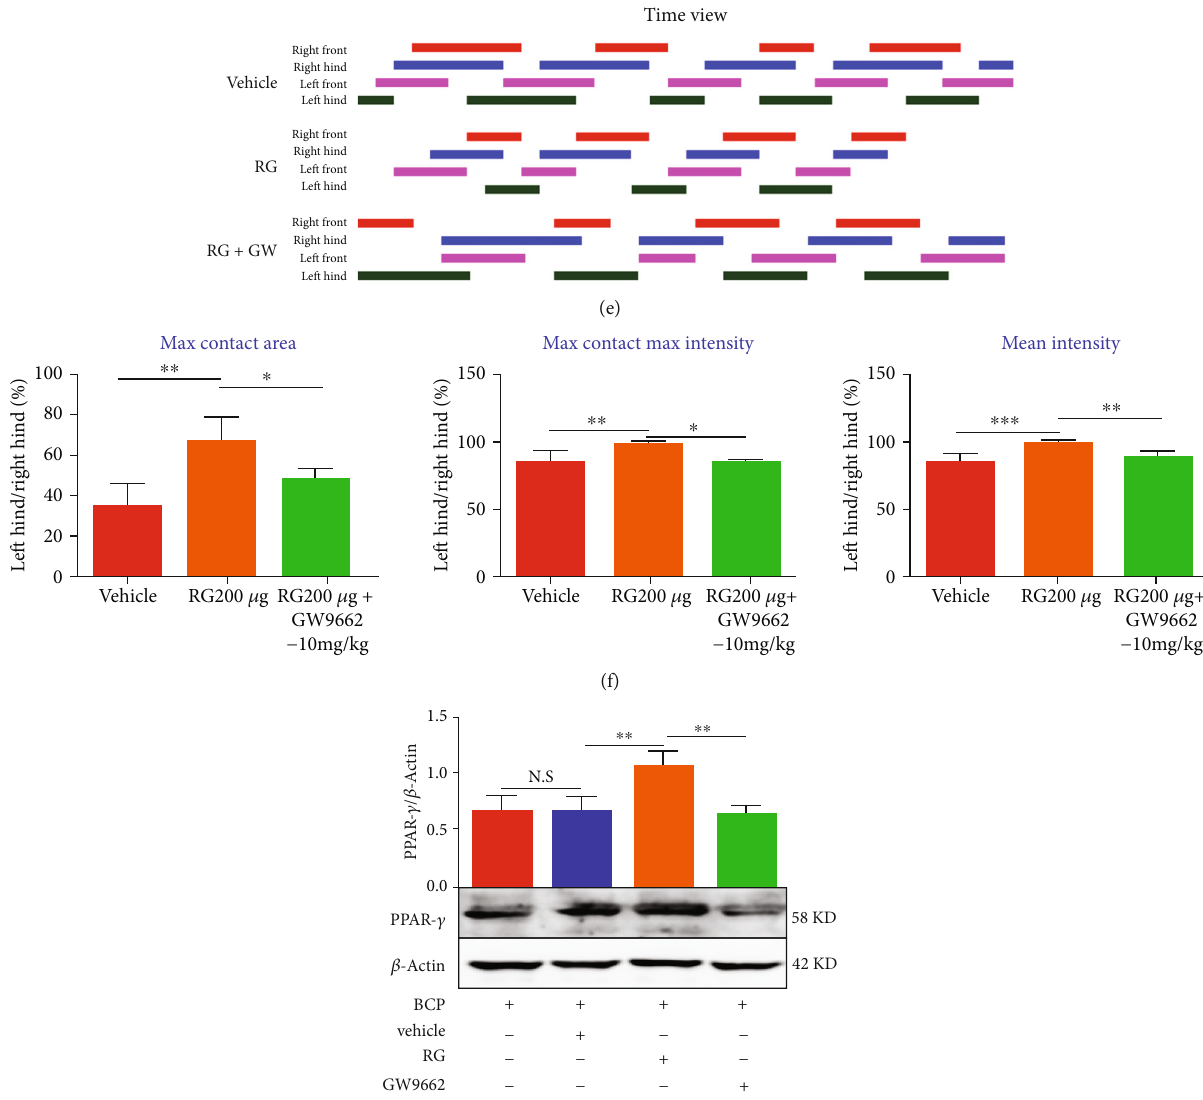
Figure 3: Rosiglitazone attenuated bone cancer pain (BCP) by activating proliferator-activated receptor- γ (PPAR- γ ). (a) Compared to that of rats in the vehicle-treated BCP group, repeated intrathecal injection of rosiglitazone at 50, 100, and 200 μ g signi fi cantly increased the paw withdrawal threshold (PWT) of BCP rats in a dose-dependent manner from postoperative days (POD) 14 – 18 ( ∗ p < 0 : 05 and ∗∗∗ p < 0 : 001 vs. the vehicle control group; n = 6 , two-way repeated measures ANOVA (a)). (b) A single dose of rosiglitazone (50, 100, and 200 μ g) reversed mechanical hypersensitivity in the later stages of BCP in a dose-dependent manner ( ∗ p < 0 : 05 , ∗∗ p < 0 : 01 , and ∗∗∗ p < 0 : 001 vs. the vehicle control group; n = 6 , two-way repeated measures ANOVA (b)). (c) The PPAR- γ antagonist GW9662 reversed the analgesic e ff ect of rosiglitazone in BCP rats ( ∗ p < 0 : 05 and ∗∗∗ p < 0 : 001 vs. the BCP+RG group; n = 6 , two-way repeated measures ANOVA (c)). Rosiglitazone and GW9662 treatment did not a ff ect the basal pain threshold of sham rats ( p > 0 : 05 vs. the vehicle control group; two-way repeated measures ANOVA (c)). (d, e) Representative CATWALK gait analysis results, including print view and timing view in the BCP, BCP+rosiglitazone, and BCP+rosiglitazone+GW9662 groups. Print area is the size of the paw print. Print time represents the related contact time. (f) Compared with those in the BCP group, the percentages of left/right hind paw ratio of maximum contact area, maximum contact maximum intensity, and mean intensity were signi fi cantly increased in the group treated with 200 μ g rosiglitazone ( ∗∗ p < 0 : 01 and ∗∗∗ p < 0 : 001 vs. vehicle control group; n = 6 , one-way ANOVA (f)), which was reversed upon treatment with GW9662 at a dose of 10mg/kg ( ∗ p < 0 : 05 and ∗∗ p < 0 : 01 vs. the BCP+RG group; n = 6 , one-way ANOVA (f)). Max contact area is the print area during maximum hind paw contact; max contact max intensity is the maximum intensity during maximum hind paw contact; and mean intensity is the average of the hind paw intensity at all time points. All data were calculated as the percentage of the ipsilateral (left)/contralateral (right) hind paw. (g) Western blotting results showed that compared with the vehicle treatment group, rosiglitazone treatment remarkably increased the expression of PPAR- γ in the spine of BCP rats ( ∗∗ p < 0 : 01 vs. the vehicle control group; n = 4 , one-way ANOVA (g)), which was reversed by preadministration of GW9662 ( ∗∗ p < 0 : 01 vs. the BCP+RG group; n = 4 , one-way ANOVA (g)). BL: baseline; GW: GW9662; RG: rosiglitazone. N.S: not statistically signi fi